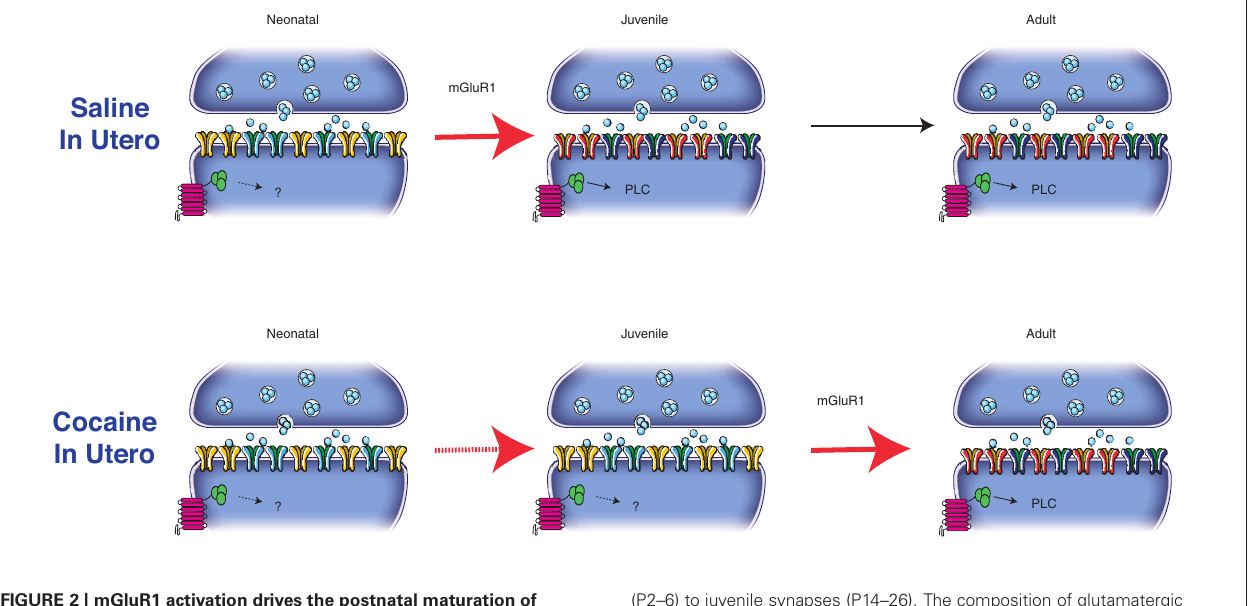
(P2–6) to juvenile synapses (P14–26). The composition of glutamatergic synapses then remains unaltered from juvenile to adult age ( P > 60). In utero cocaine exposure interfere with the mGluR1-signaling pathway delaying the postnatal maturation of excitatory transmission at these